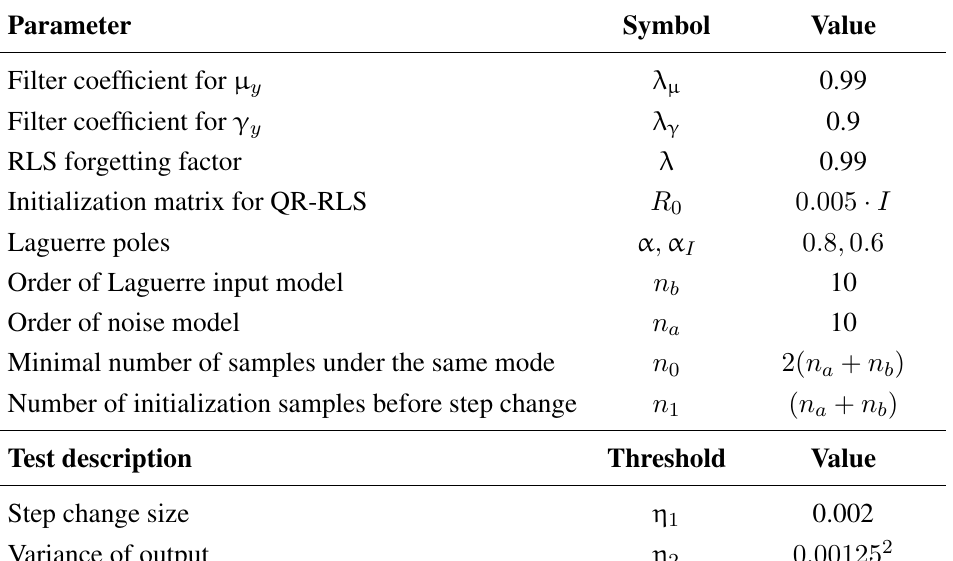
Table 1. Parameters and thresholds used.